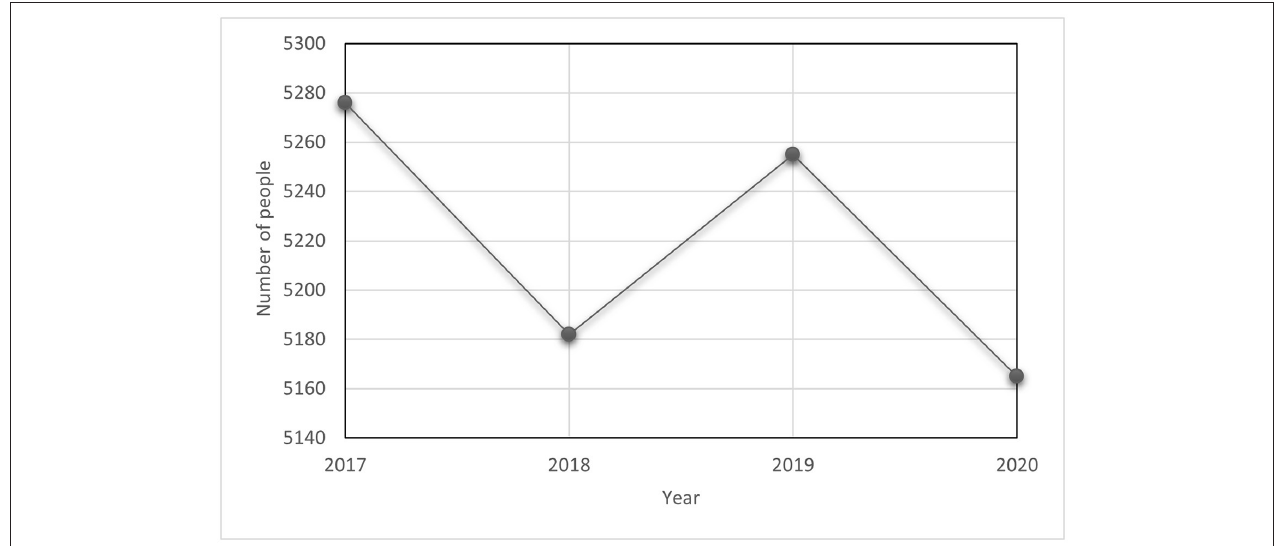
FIGURE 3 | Number of people in fatal suicide attacks in Poland in 2017–2020. Own study based on: https://statystyka.policja.pl/st/wybrane-statystyki/zamachy-